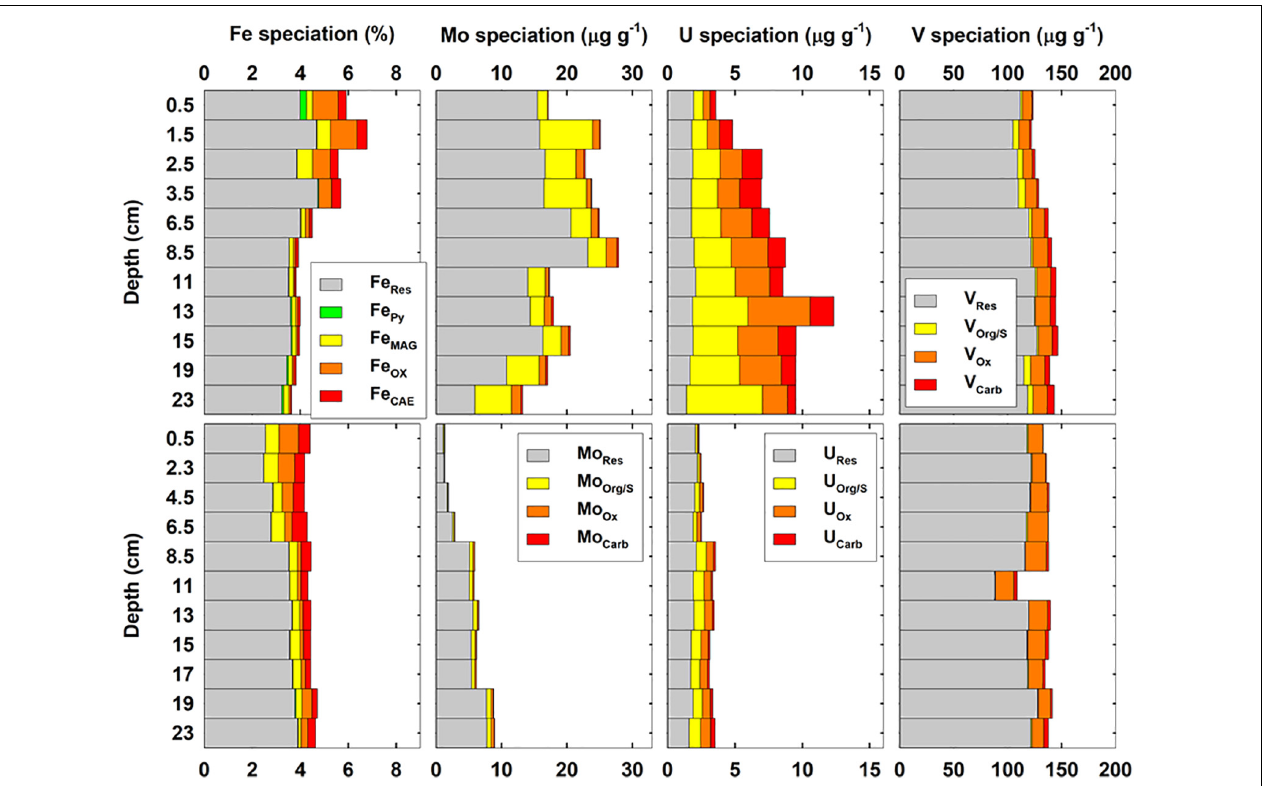
FIGURE 6 | Distribution of Fe, Mo, U, V speciation in sediments of the southern Okinawa Trough shown as absolute concentration in sediments (ROV10-1, upper panels and ROV10-2, lower panels). Highly reactive Fe (Fe HR ) fractions include carbonate (Fe CAE ), oxides (Fe OX ), magnetite (Fe Mag ), and pyrite (Fe Py ). Residual Fe (Fe Res ) is the difference between total Fe and Fe HR . Similarly, labile RSEs (X = Mo, U, V) include the fractions of RSEs bound within carbonates (X Carb ), Fe/Mn oxides (X Ox ), organic/sulfides (X Org / S ). See text for further